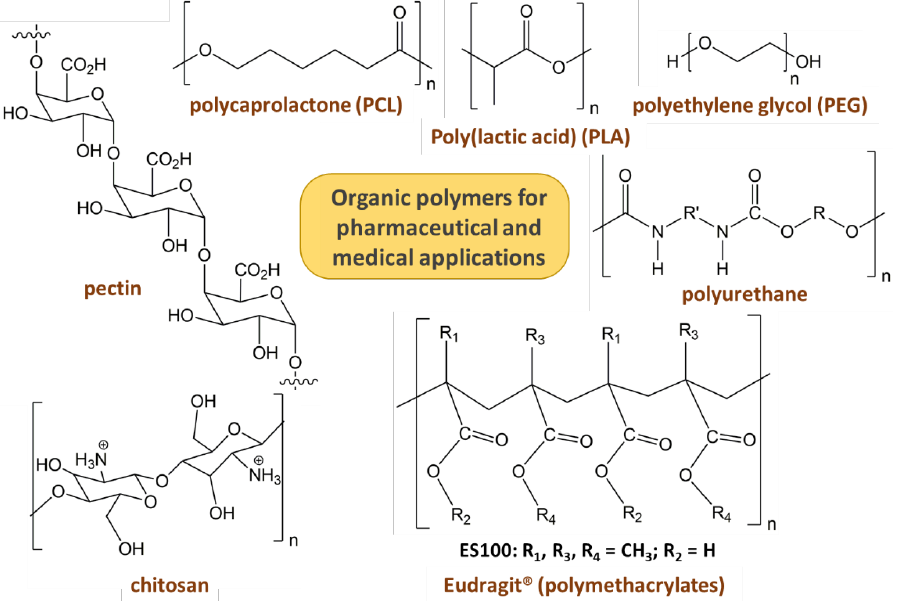
Figure 3. Chemical structures of some natural and synthetic organic polymers are used to